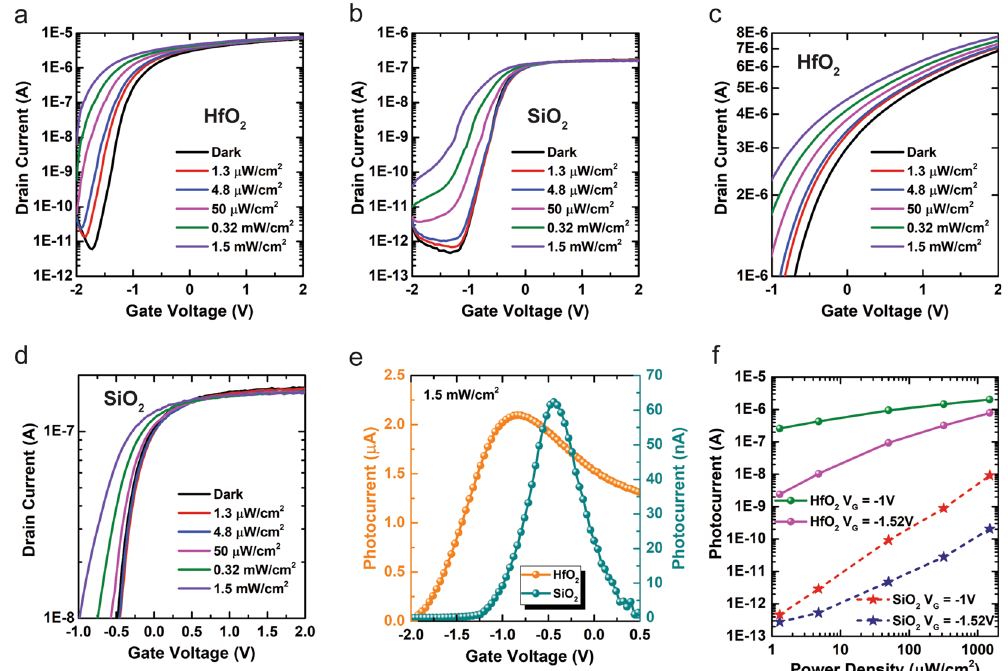
Fig. 2 Photoresponse of MoS 2 phototransistors. Effects of light illumination with blue LED at different optical power densities at V DS = 150 mV for a HfO 2 phototransistor and b SiO 2 phototransistor. Close-up of the illumination curves in the accumulation mode region of c the HfO 2 phototransistor and d the SiO 2 phototransistor. e Photocurrent generation comparison of HfO 2 and SiO 2 phototransistors under illumination at 1.5 mW cm − 2 . f Photocurrent ( I PH ) versus optical power density under varying gate voltages and constant V DS = 150